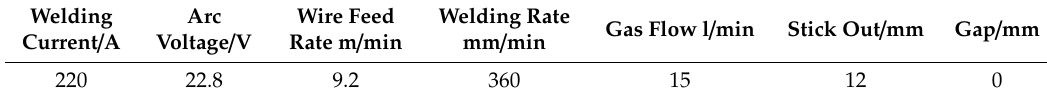
Table 2. Welding parameters of T4003 ferritic stainless steel plate.